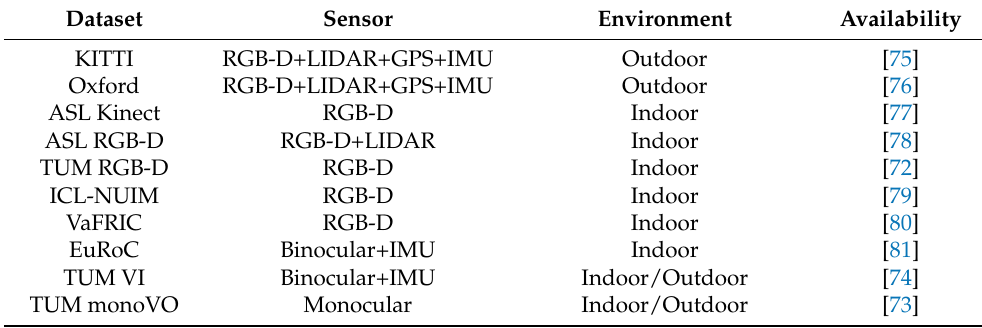
Table 4. Common datasets in SLAM